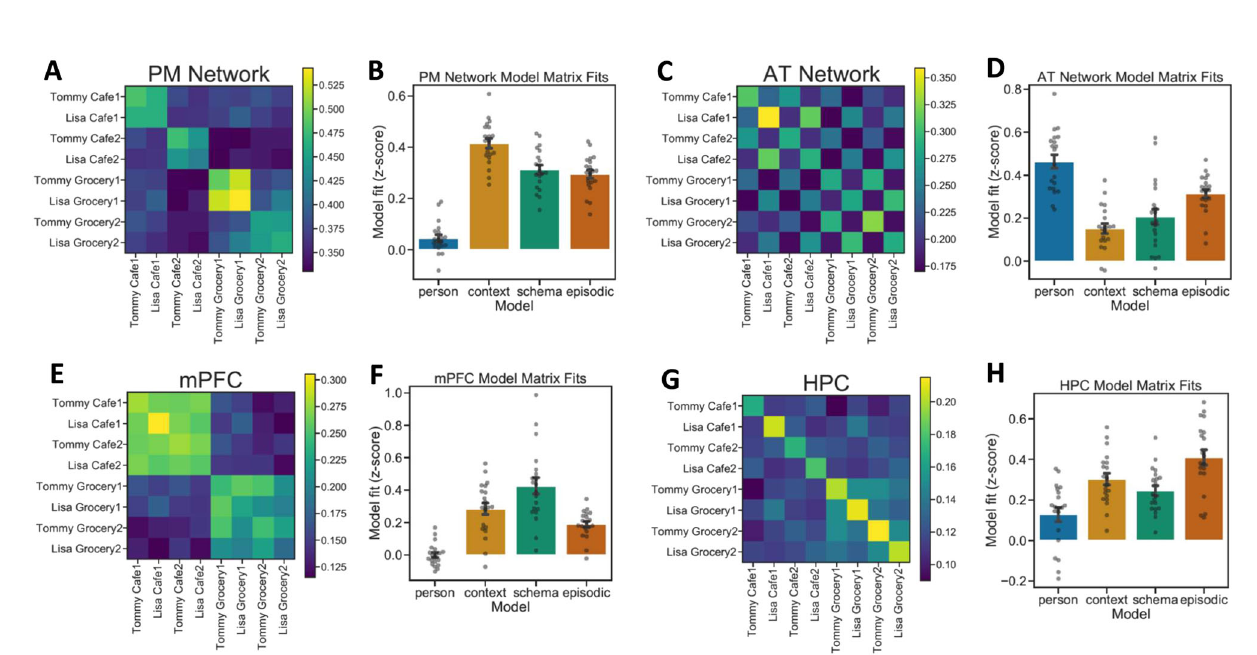
Fig. 3 | Across-event pattern similarity at encoding. A , B PM Network pattern similarity results most strongly fi t the Context model matrix. C , D AT Network pattern similarity results most strongly fi t the Person model matrix. E , F mPFC